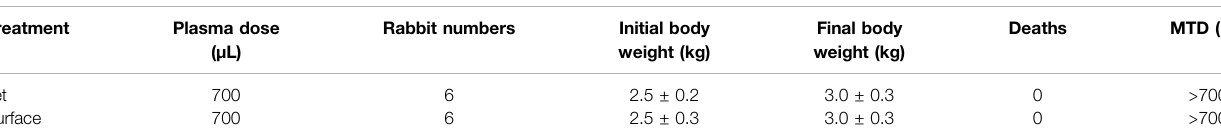
TABLE 1 | Acute toxicity tests of PAL treatments of New Zealand rabbits.